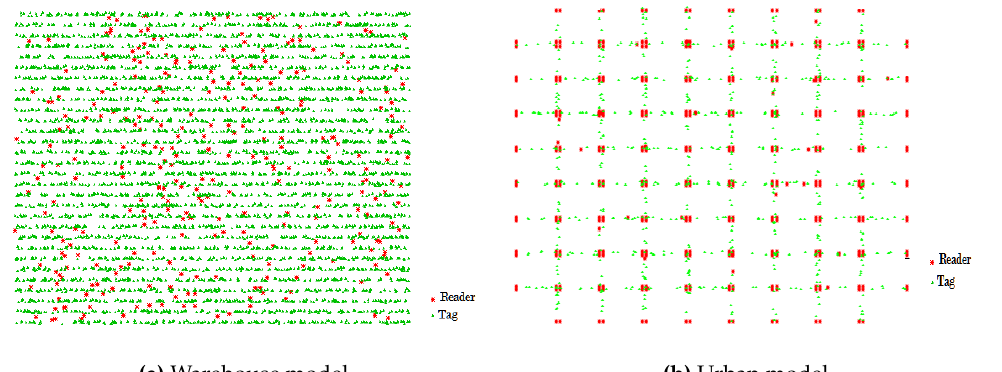
Figure 9. Dynamic deployment